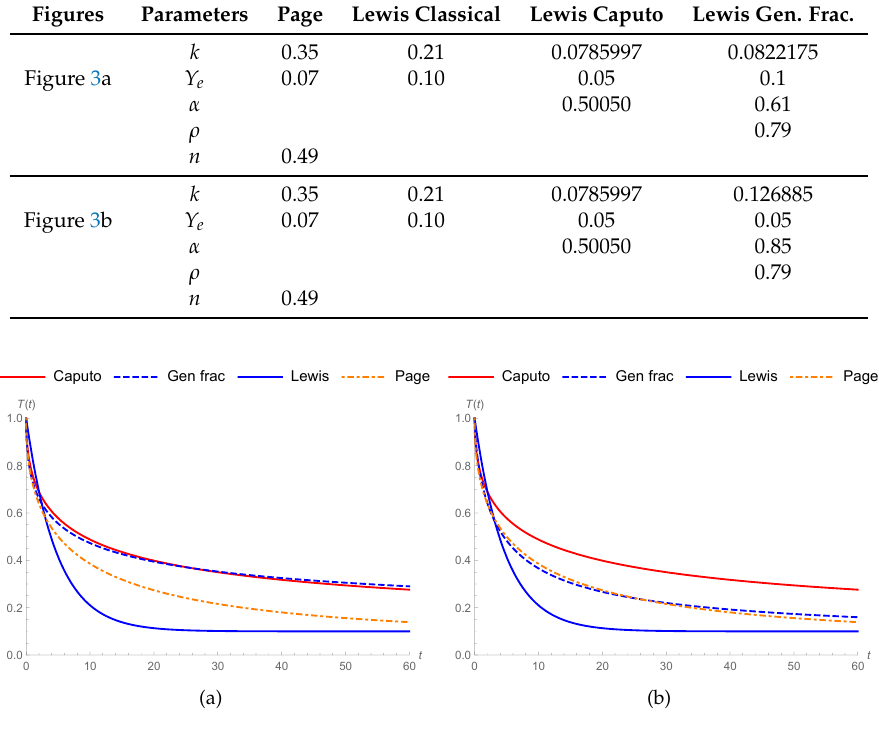
Figure 3. Comparison of drying kinetics for soybean under different models at 70 ◦ C: ( a , b ) Parameter values are shown in Table 3. Table 4. Parameter values of models [41].